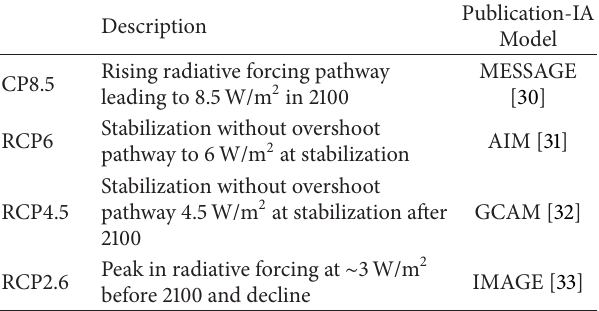
Table 1: Description of